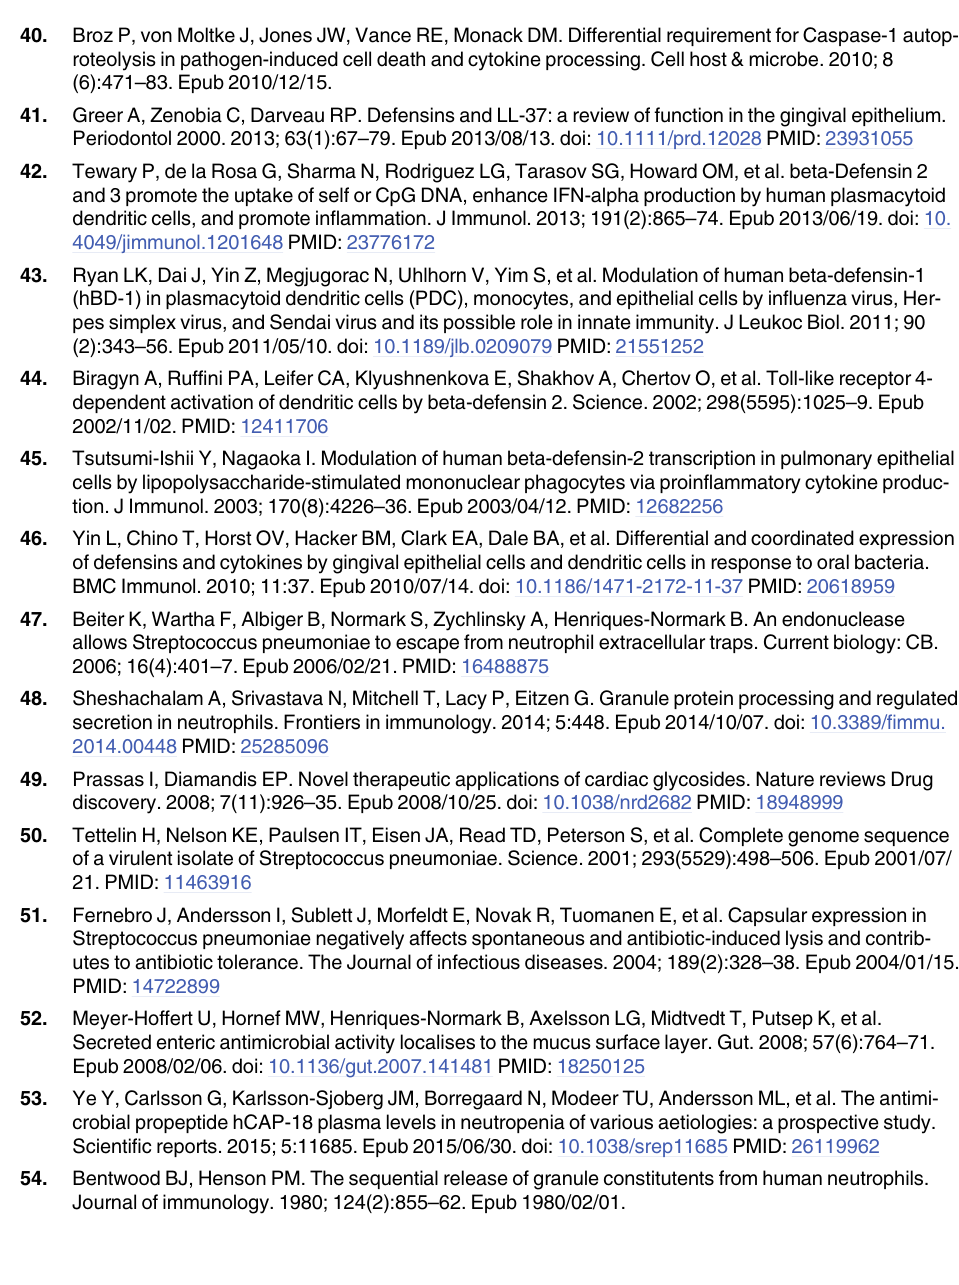
PLOS ONE | DOI:10.1371/journal.pone.0160734 August 16,